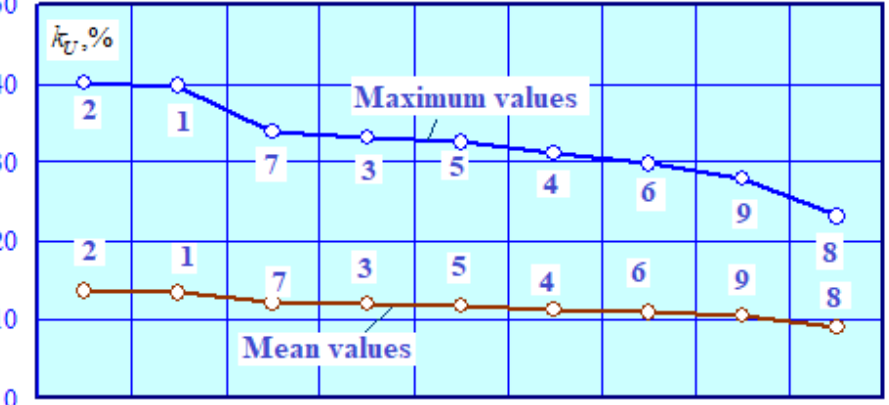
Figure 20. Maximum total harmonic distortion values at 220 kV buses of TS No. 4—callout num- bers correspond to those in Figure 15.